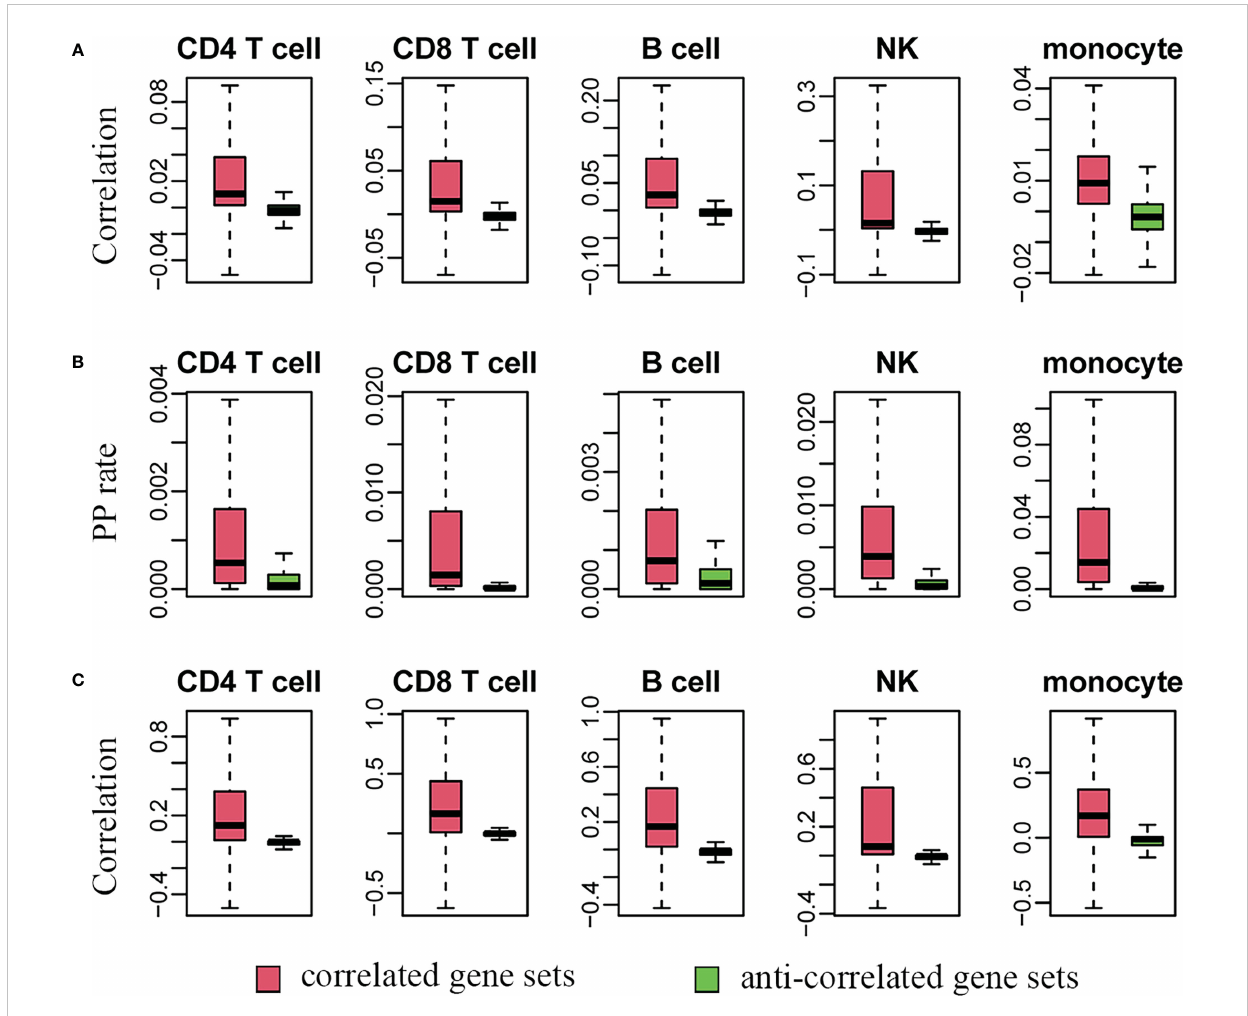
FIGURE 6 The single-cell transcriptome supports the virtual sorting results derived from bulk RNA sequencing data. (A, C) indicate the distributions of Pearson correlation coef fi cients before and after imputation by SAVER. A higher correlation (A) and coexistence rate or present-present/PP rate (B) between highly plastic genes and their correlated genes are also observed in the single-cell dataset. After imputation, the correlation strength is further greatly improved (C)